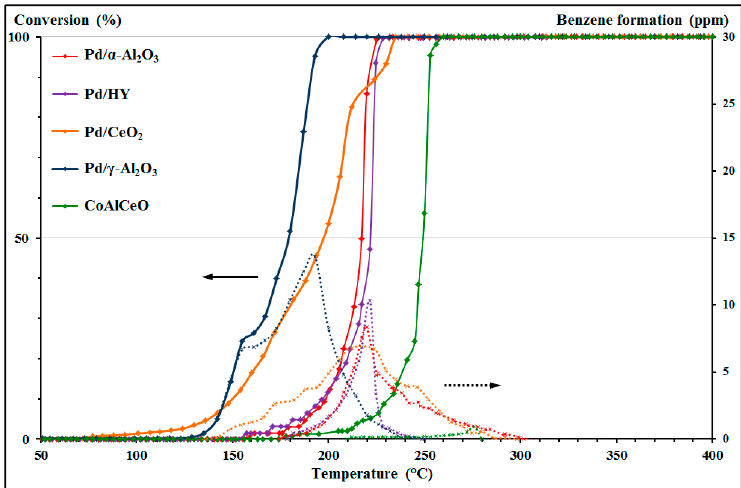
Figure 2. Toluene conversion (solid arrow and lines) and benzene formation (dashed arrow and lines) versus temperature for each